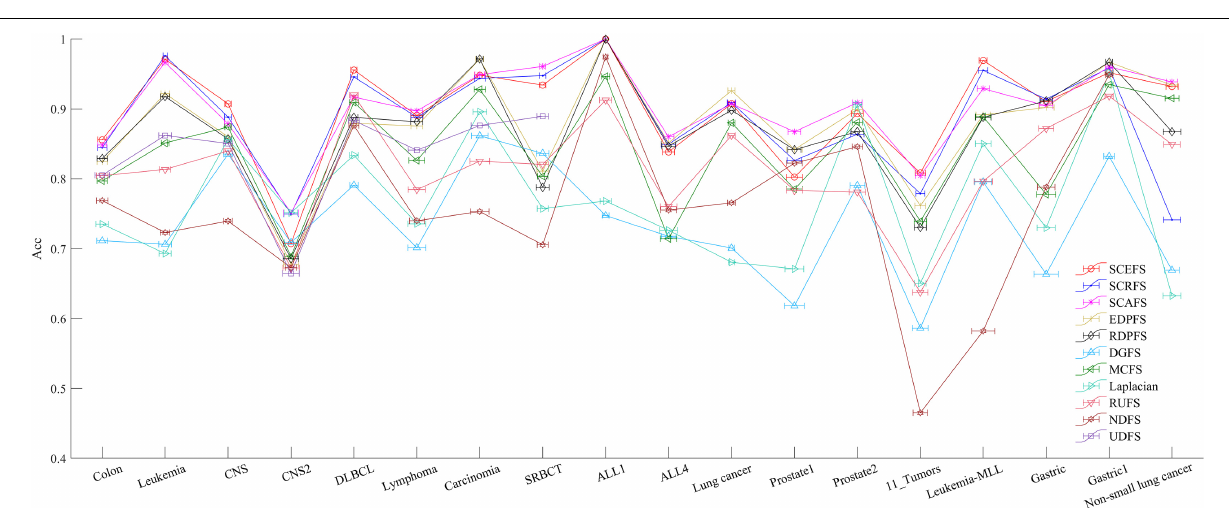
FIGURE 6 | The maximal mean Acc comparison of each algorithm on 18 datasets using KNN